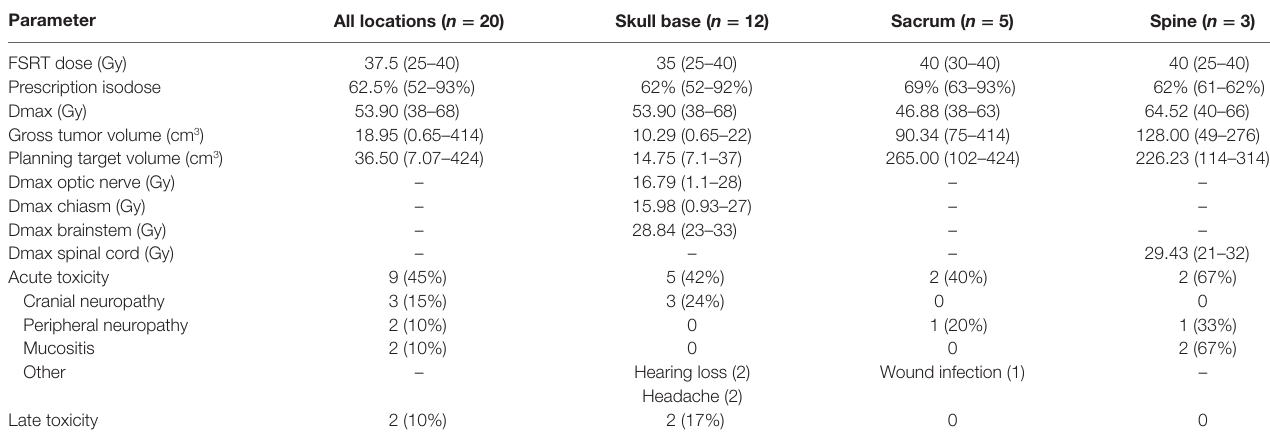
Table 2 | Fractionated stereotactic radiotherapy (FSRT) dosimetry details and toxicity for chordoma and chondrosarcoma patients. Parameter all locations ( n =